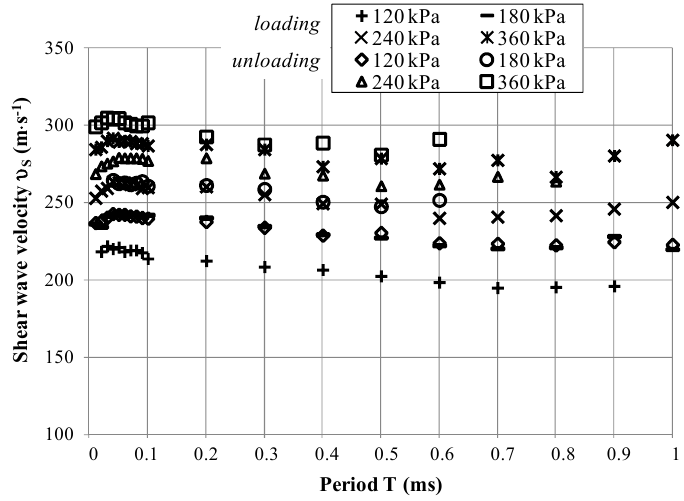
Figure 18. Shear wave velocity versus period at the loading and unloading stage.